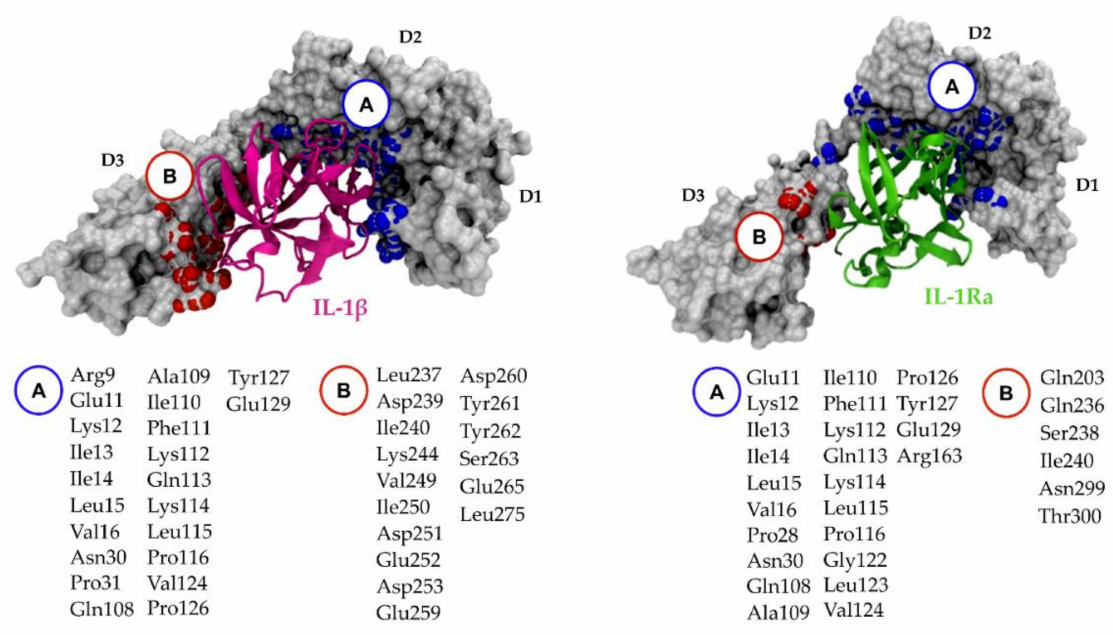
Figure 5. Structures of the binary IL-1R1-ECD/IL-1 β (PDB entry 1ITB) and IL-1R1-ECD/IL-1Ra (PDB entry 1IRA) complexes. In both panels, IL-1R1-ECD is depicted in the surface representation (gray), while IL-1 β (magenta) and IL-1Ra (lime) are shown in cartoon representations. The two binding regions are shown as spheres and colored in blue (site A) and red (site B), respectively. Left panel: IL-1 β interacts with the two sites on the receptor surface (IL-1R1-ECD residues involved are presented in blue and red). Right panel: IL-1Ra interacts mostly with site A (IL-1R1-ECD residues involved are presented in blue and red). Figure abbreviations: IL-1 β , interleukin-1 β ; IL-1R1-ECD, extracellular domain of IL-1R1; IL-1Ra, interleukin 1 receptor